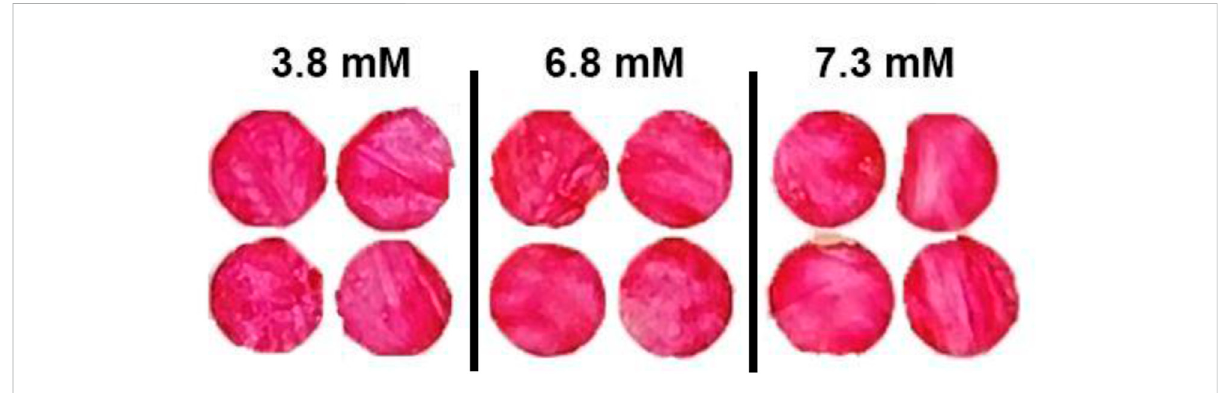
FIGURE 5 Effect of fresh blood on the colorimetric properties for nanocellulose sensor for reading after 7 min for glucose concentrations of 3.8 to 7.3